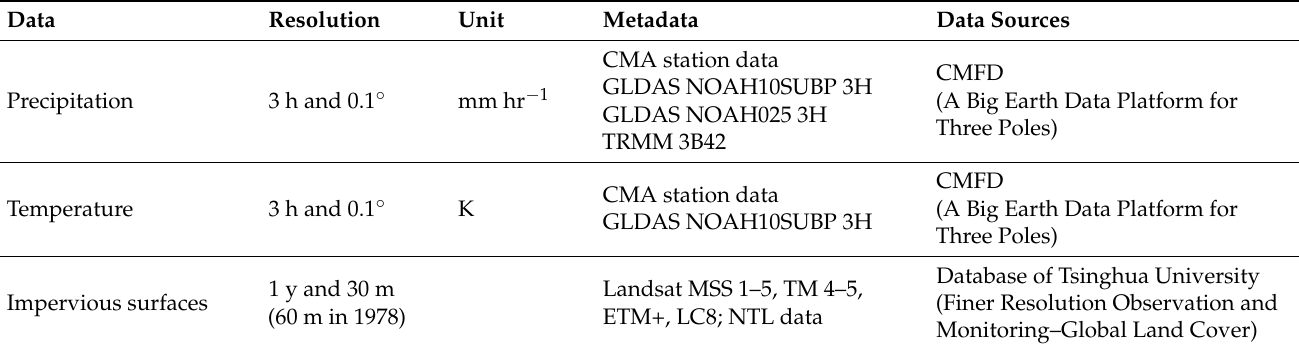
Table 1. Description of data source.